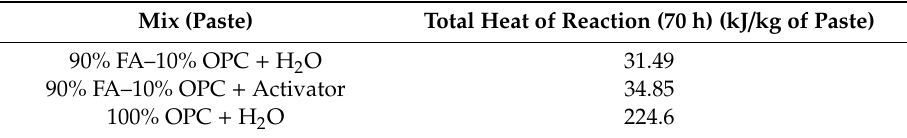
Figure 6. Total heat of reaction of the pastes. Table 3. Total heat of reaction of the pastes up to 70 h of testing. Table 3. Total heat of reaction of the pastes up to 70 h of testing.